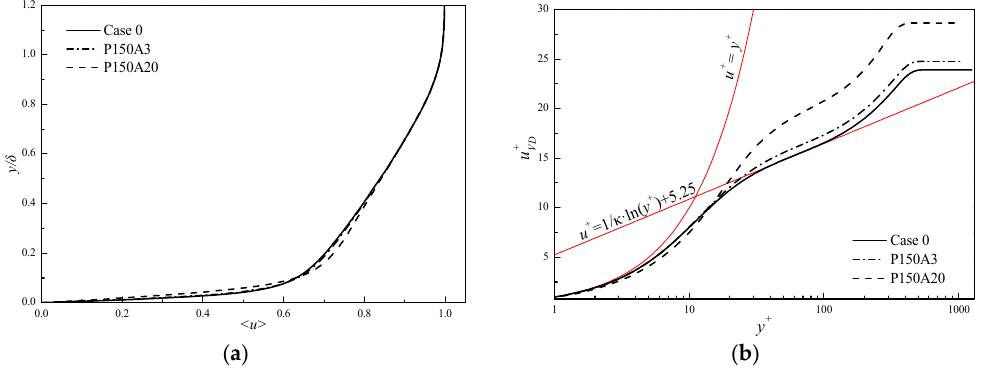
Figure 10. Mean velocity profile in outer scaling ( a ) and inner scaling ( b ) at x = 40.775. The local wall variables are used to normalize y ` and u ` in ( b VD